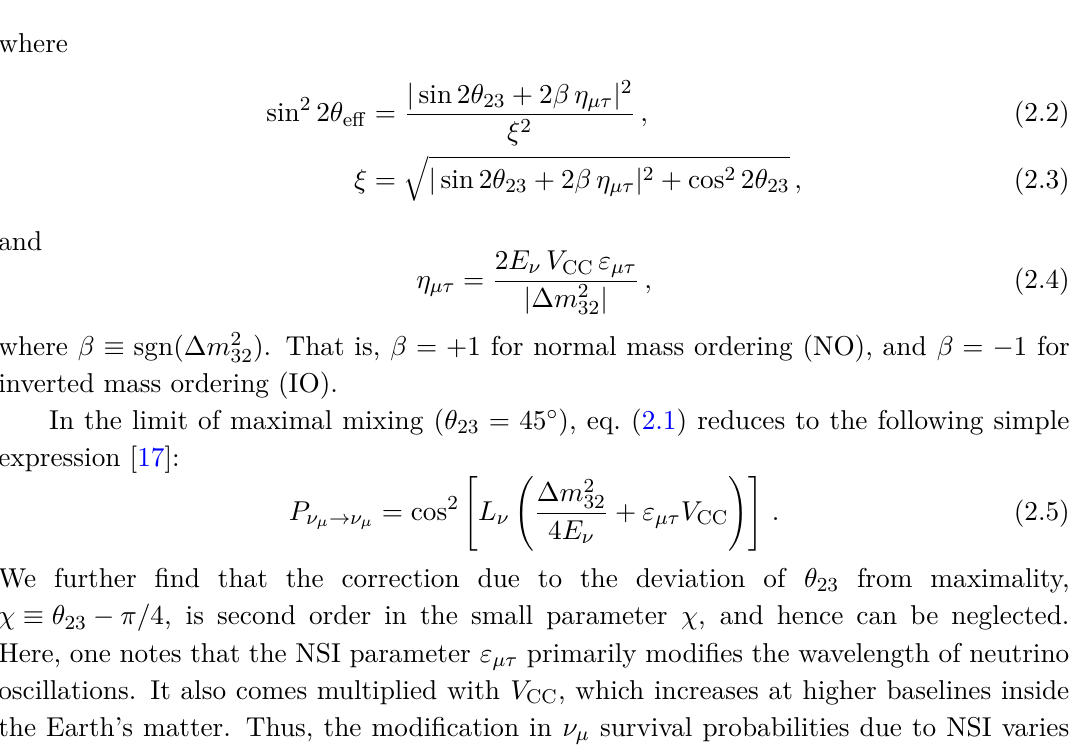
Table 2 . The benchmark values of oscillation parameters that we use in the analysis. Normal mass ordering corresponds to m 1 < m 2 < m 3